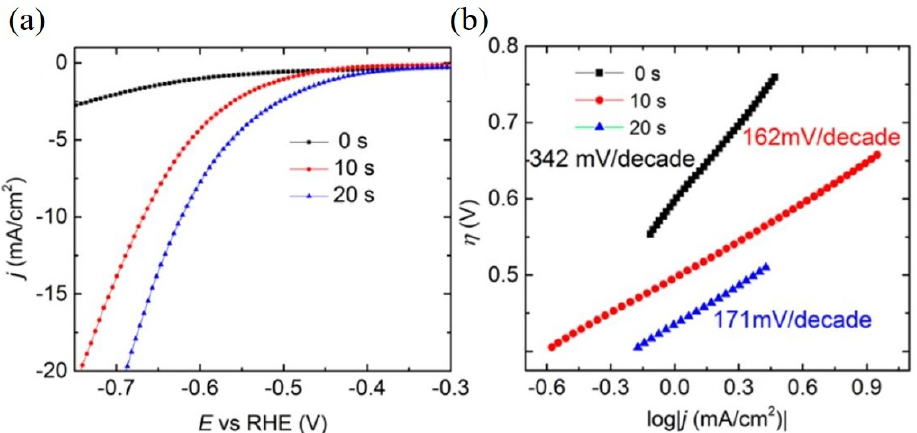
Figure 3. Hydrogen evolution reaction (HER) properties of single-layer MoS 2 with different oxygen plasma treatment times (0, 10, and 20 s). ( a ) Linear sweep voltammetry (LSV) curves show a positive correlation between the HER activity enhancement of single-layer MoS 2 and the plasma exposure time at the cathodic sweep of the first cycle. ( b ) Tafel plots show the better performance in electrochemical activity of the single-layer MoS 2 catalyst after 20 s oxygen plasma treatment [37].